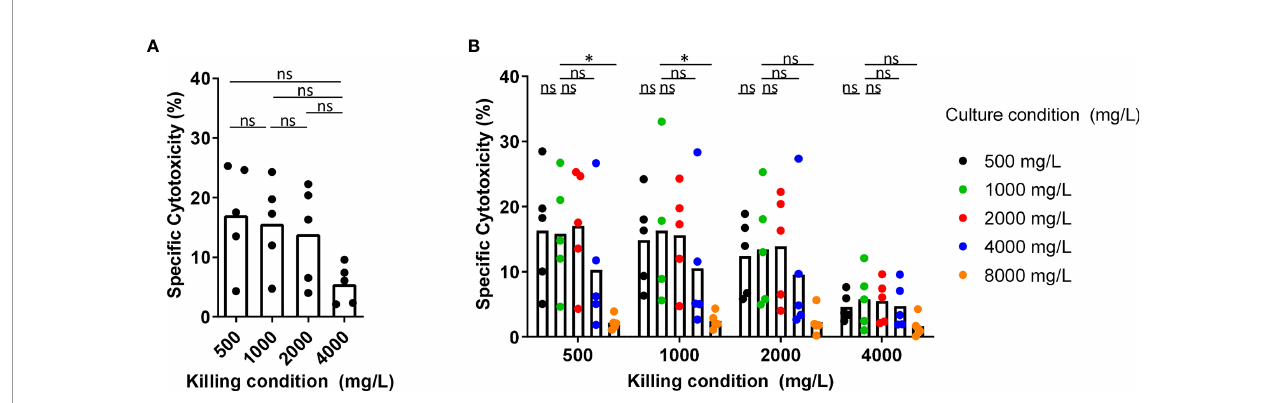
FIGURE 2 | Short-term exposure to lower glucose concentrations does not reduce NK cell cytotoxicity while higher glucose levels reduce NK cell cytotoxicity. (A) NK cells were overnight activated with IL-2 in standard RPMI-1640 medium with 2000 mg/L glucose, followed by a 4h cytotoxicity assay with K562 cells at 1:1 E:T ratio in different glucose concentrations (killing condition). (B) NK cells were cultured in different glucose concentrations overnight (culture condition) in presence of IL-2, followed by a 4h cytotoxicity assay with K562 cells at 1:1 E:T ratio in different glucose concentrations (killing condition). Tumor cells killed by NK cells are denoted as percentage speci fi c cytotoxicity. Bars show the average of n=5 donors in 3 independent experiments. Each dot represents the average of a technical duplicate. *p < 0.05. ns, not signi fi